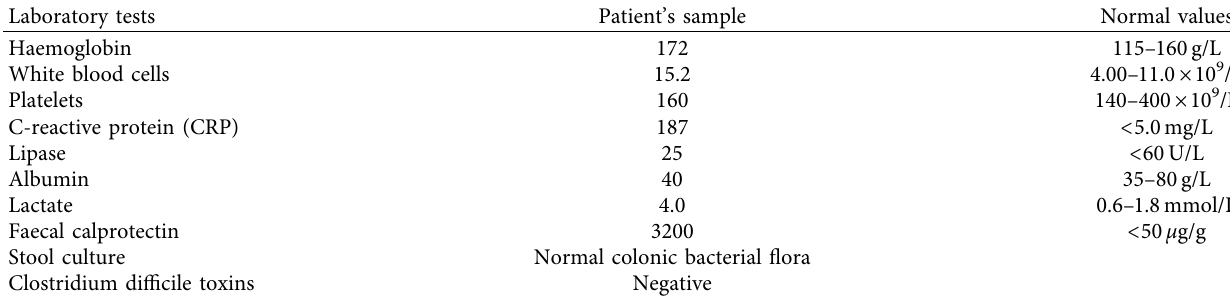
Table 1: Laboratory results.